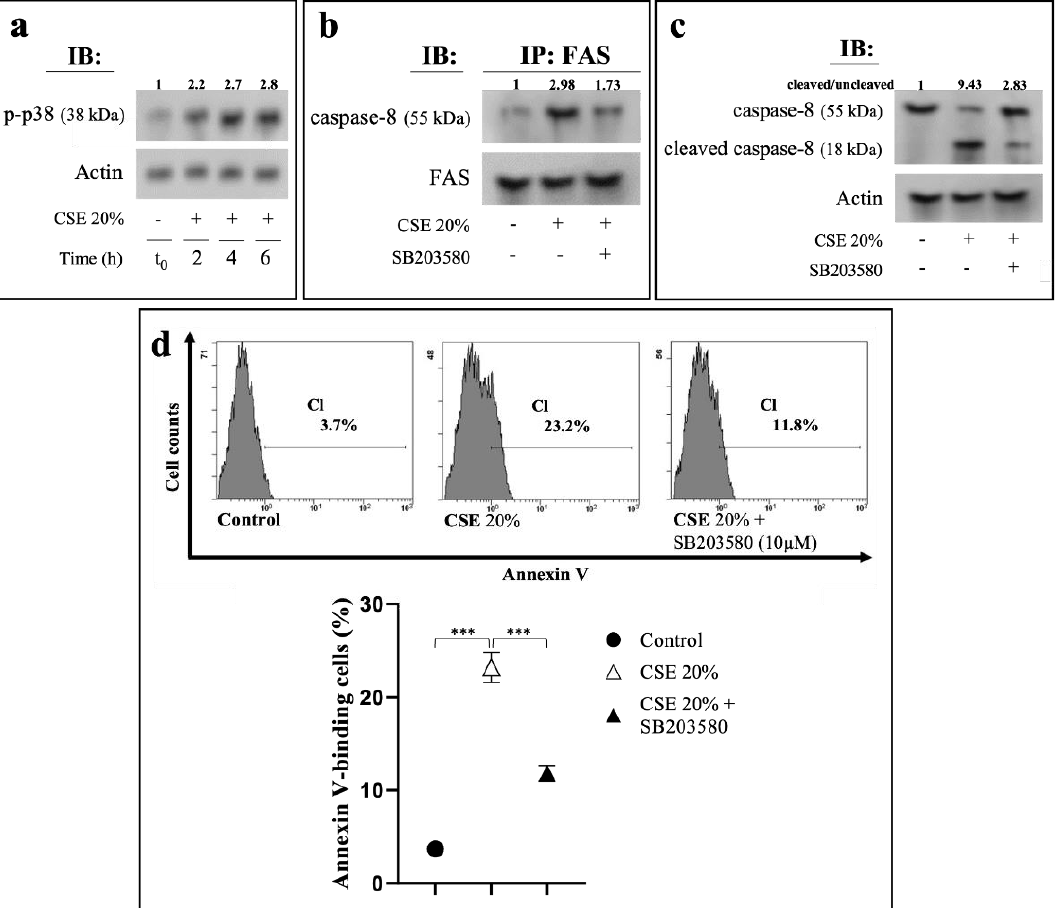
Figure 5. CSE-induced eryptosis is dependent by p38 MAPK activation. ( a ) Western blot analysis of p-p38 in RBC treated at different time intervals with CSE. ( b ) Association of Fas with caspase-8 in RBC treated with CSE in the absence or in the presence of p-38 MAPK inhibitor. RBCs were pre-incubated for 1 h in the absence or in the presence of 10 µ M SB203580 before 6 h treatment with 20% CSE. Immunoprecipitation with anti-Fas antibody and immunodetection of caspase-8. Blots were reprobed with anti-Fas antibody to ensure equal loading of the gels. ( c ) Western blot analysis of caspases-8. The numbers below each line represent the relative expression level normalized to actin, as determined on the basis of the intensity of the band. Representative image of three experiments with similar results. ( d ) Percentage of PS-exposing cells in RBCs pre-incubated for 1 h in the absence or in the presence of SB203580 (10 µ M) before the treatment with CSE for 6 or 24 h, respectively. RBCs incubated with vehicle were used as control. Values are means ± SD of six independent experiments carried out in triplicate. *** p < 0.001 (ANOVA associated with Tukey ’ s test).